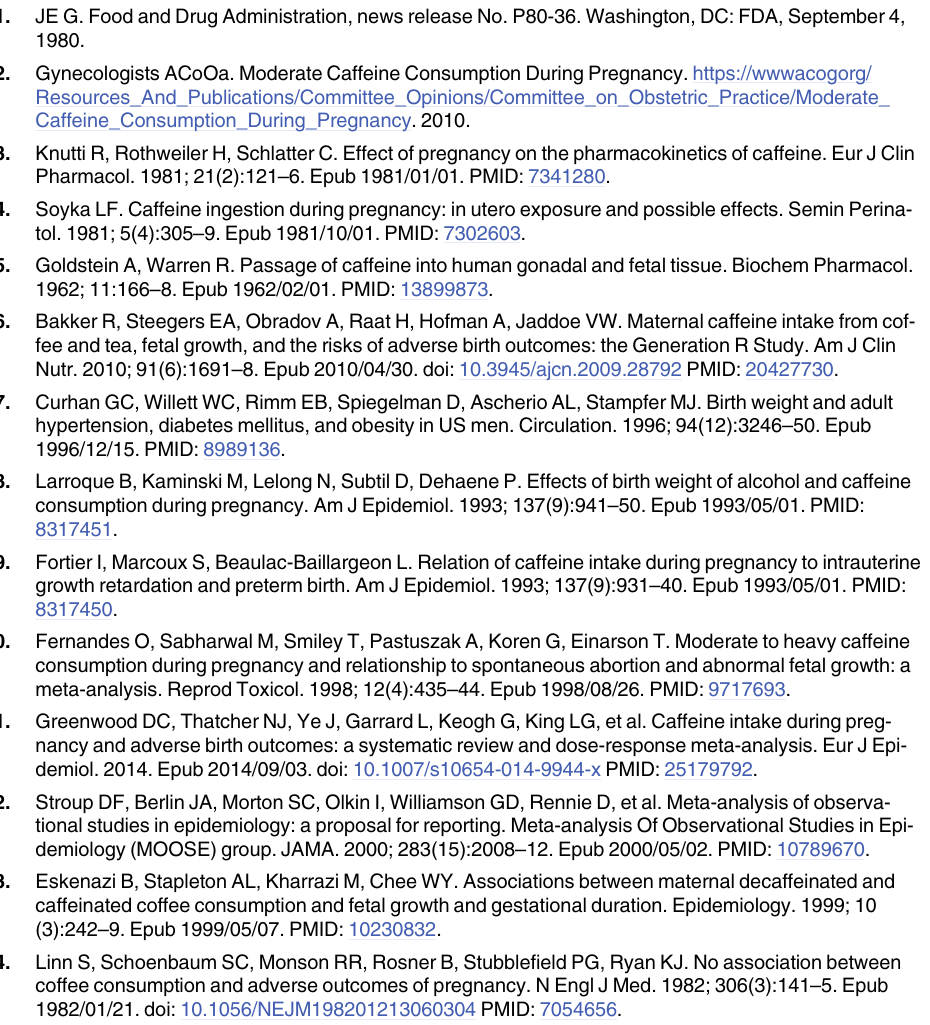
S3 Table. Data used for meta-analysis (highest vs lowest).